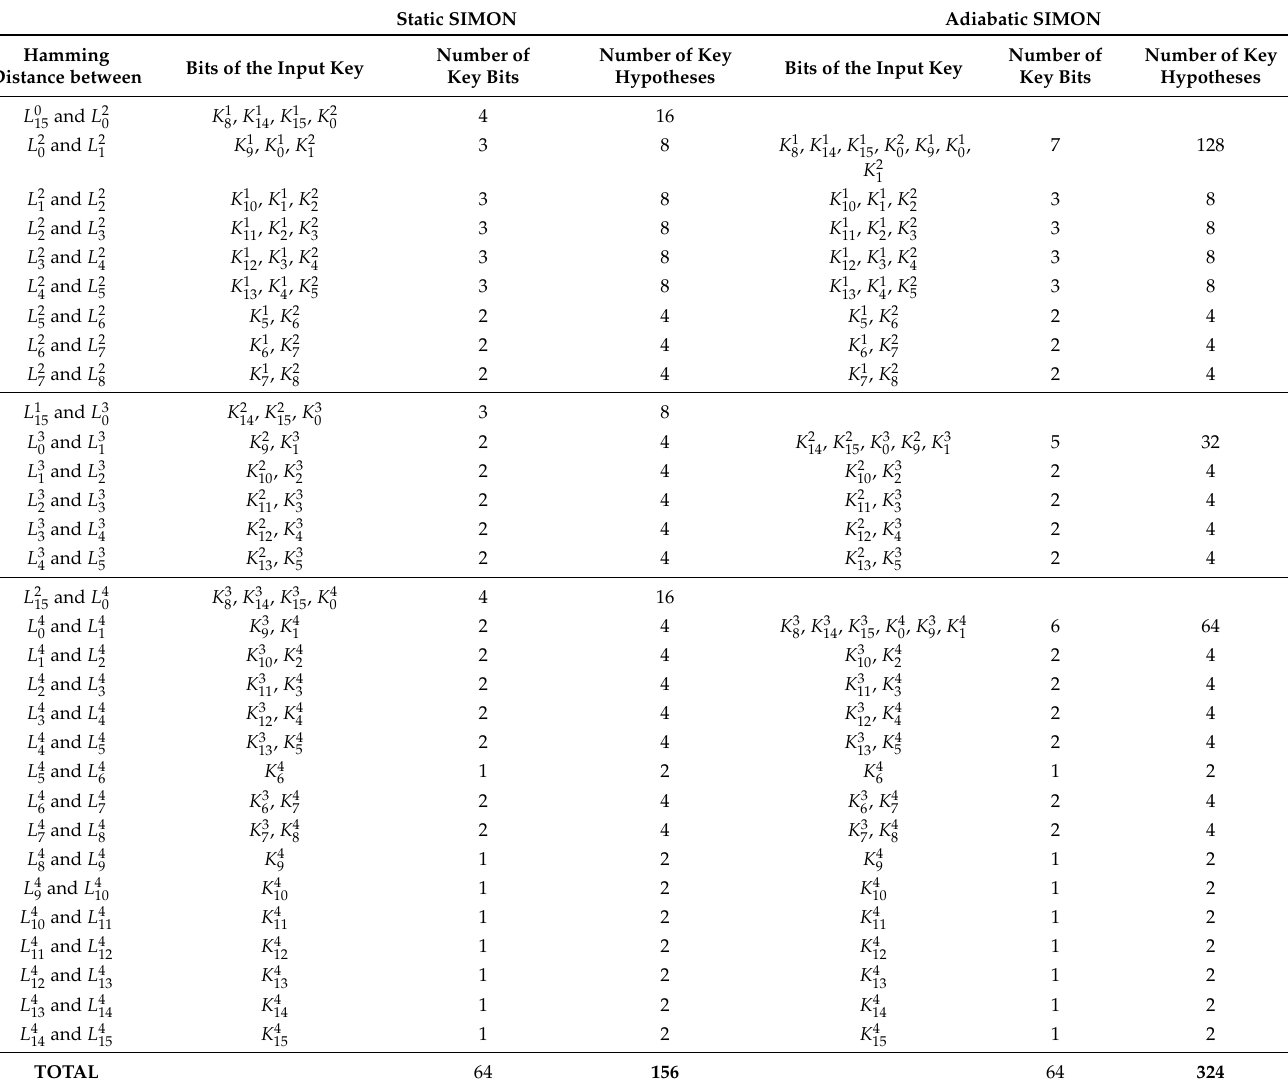
Table 1. Complexity of the CPA attack for static CMOS based SIMON32/64 and adiabatic SIMON32/64 implementations: power model and number of key hypotheses required. L m n refers to the n th bit of the left block output of the m th round and K m n refers to the n th bit of the m th word of the input 64-bit